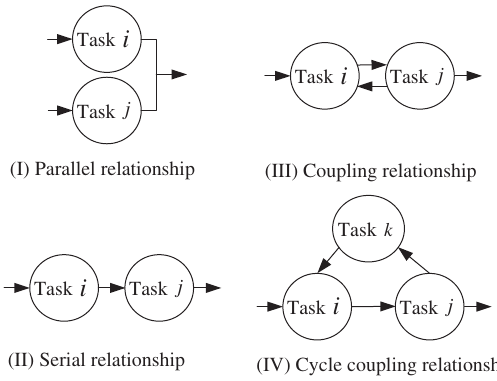
Figure 3: The Four Kinds of Relationship Between Two